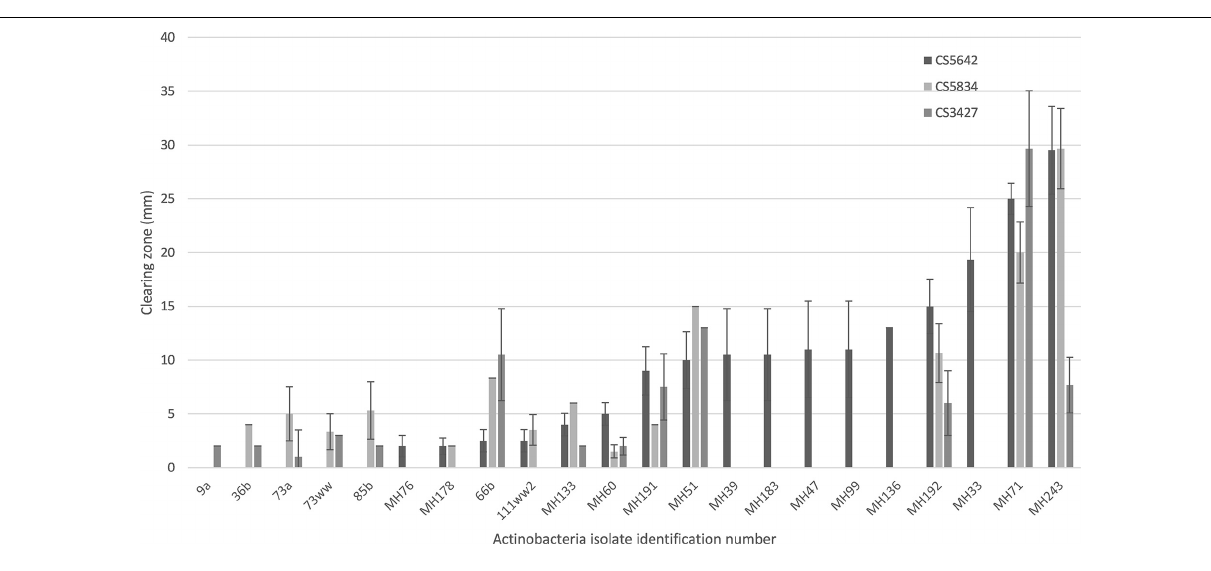
FIGURE 4 | Selected results for the suppression of growth of three different strains of F. pseudograminearum by a range of Actinobacteria isolates measured as suppression zones (mm) on in vitro plate tests. Results for isolates with non-zero suppression zones against at least one F. pseudograminearum strain shown. Full data set is shown in Supplementary Table 3